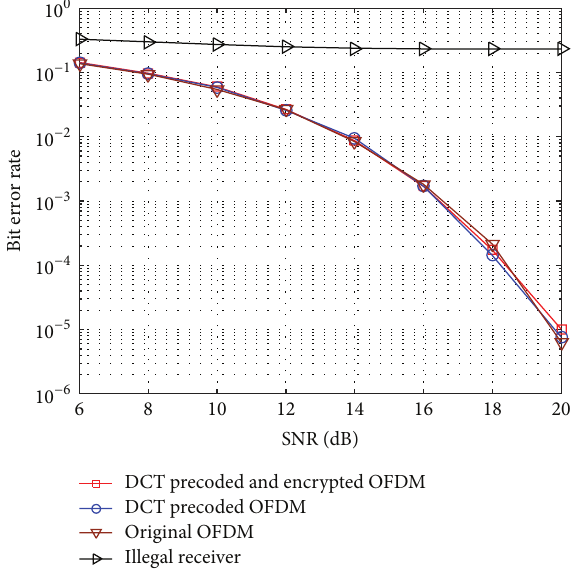
Figure 9: BER performance for AWGN